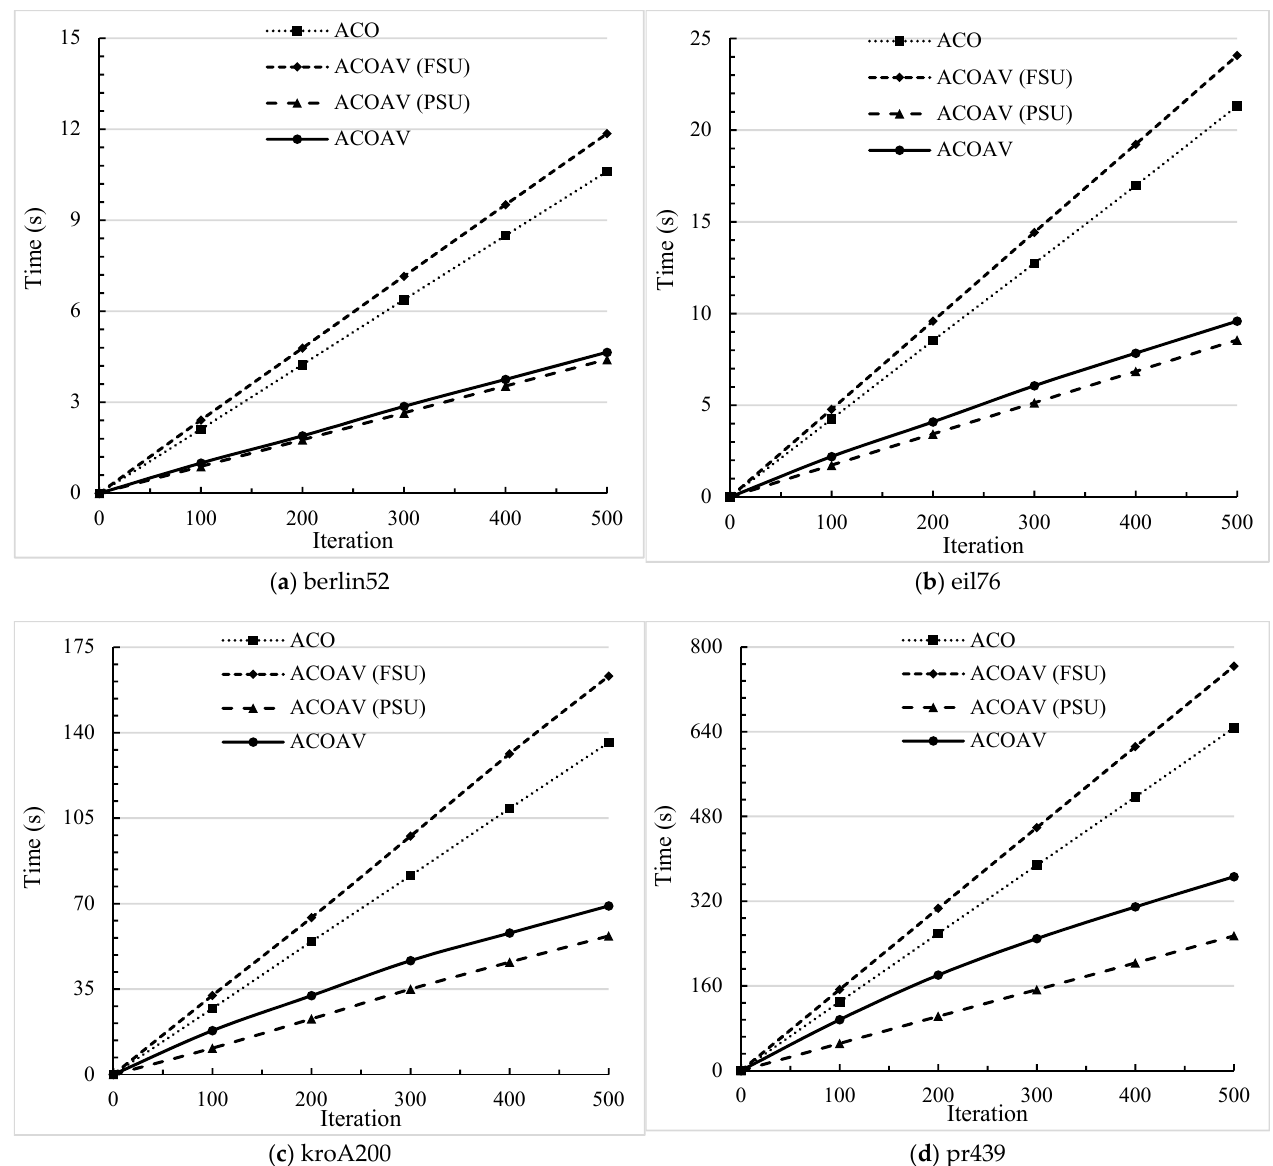
Figure 5. Process time (in the second) comparison over iterations for conventional ACO, with different methods with adaptive visibility in different modes. ACOAV (FSU) is ACO + AV with full solution update mode, ACOAV (PSU) is ACO + AV with partial solution update mode, and ACOAV is the proposed model as ACOAV (PSU) + 3-Opt.